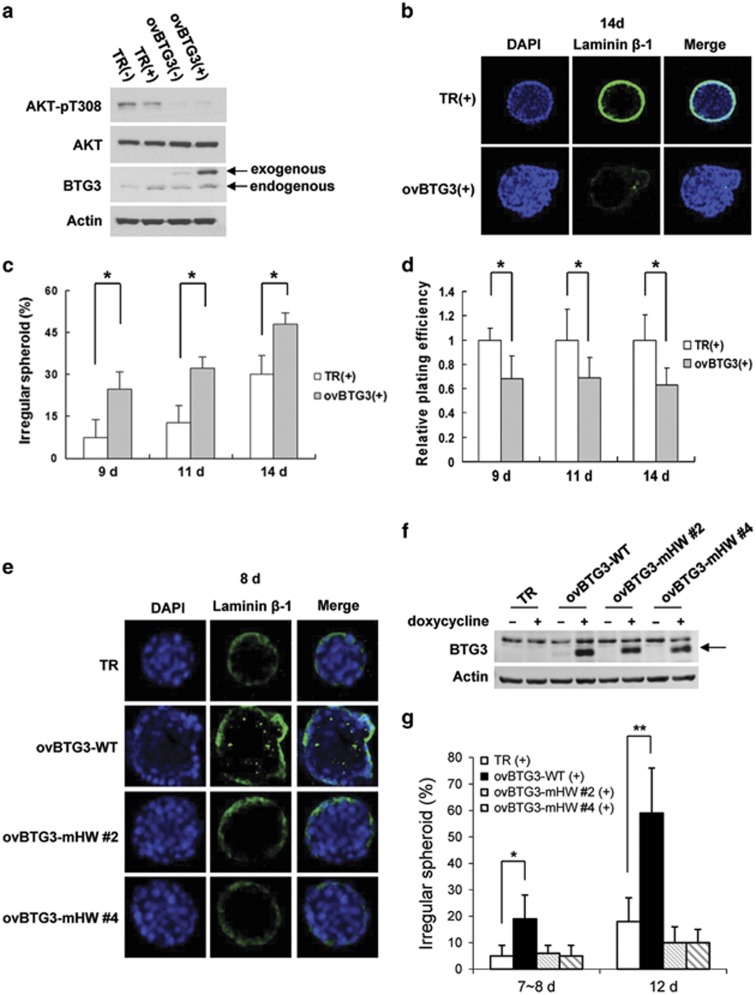
BTG3 suppresses growth of PC3 prostate cancer cells in 3D culture. (a) Characterization of PC3 Tet-On cells that express myc-tagged BTG3 upon the addition of doxycycline (+). TR, control cells that express only the tetracycline regulator; ovBTG3, Tet-On BTG3-overexpressing cells (clone no. 6). AKT T308 phosphorylation (pT308) was downregulated in ovBTG3 cells. (b) Immunofluorescence microscopy of spheroids grown in 3D culture. Shown are representative images of spheroids undergoing polarized differentiation, forming a lumen (upper panel); and spheroids with disrupted polarization (lower panel). (c and d) BTG3 overexpression disrupted the polarized growth of PC3 cells (c), and reduced the plating efficiency in 3D culture (d). The mean±S.D. of three independent experiments is shown. (e–g) The BTG3-mHW mutant failed to disrupt the polarized growth in 3D culture. Representative microscopic images are shown in (e), and expression of the wild-type (WT) and mHW BTG3 proteins in Tet-On PC3 cells, as examined by western blotting, is shown in (f). Quantitative results from four independent experiments are shown in (g). *P<0.05 and **P<0.01, respectively, by Student's t-test